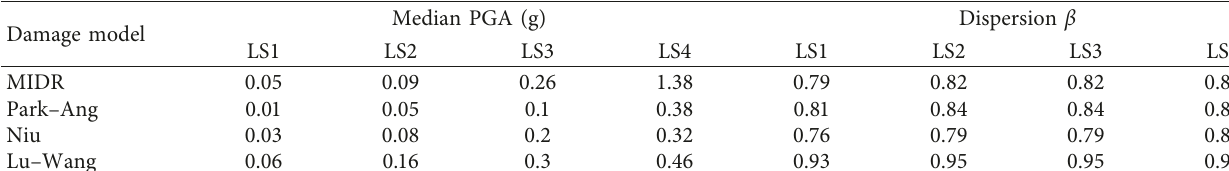
Figure 12: Fragility curves of the fixed-base and SSI models with MIDR:(a) slight damage, (b) moderate damage, (c) severe damage, and (d) complete damage. Table 8: Parameters of the fragility functions in terms of PGA for the analysed structural models with considering SSI by adopting IMDR and